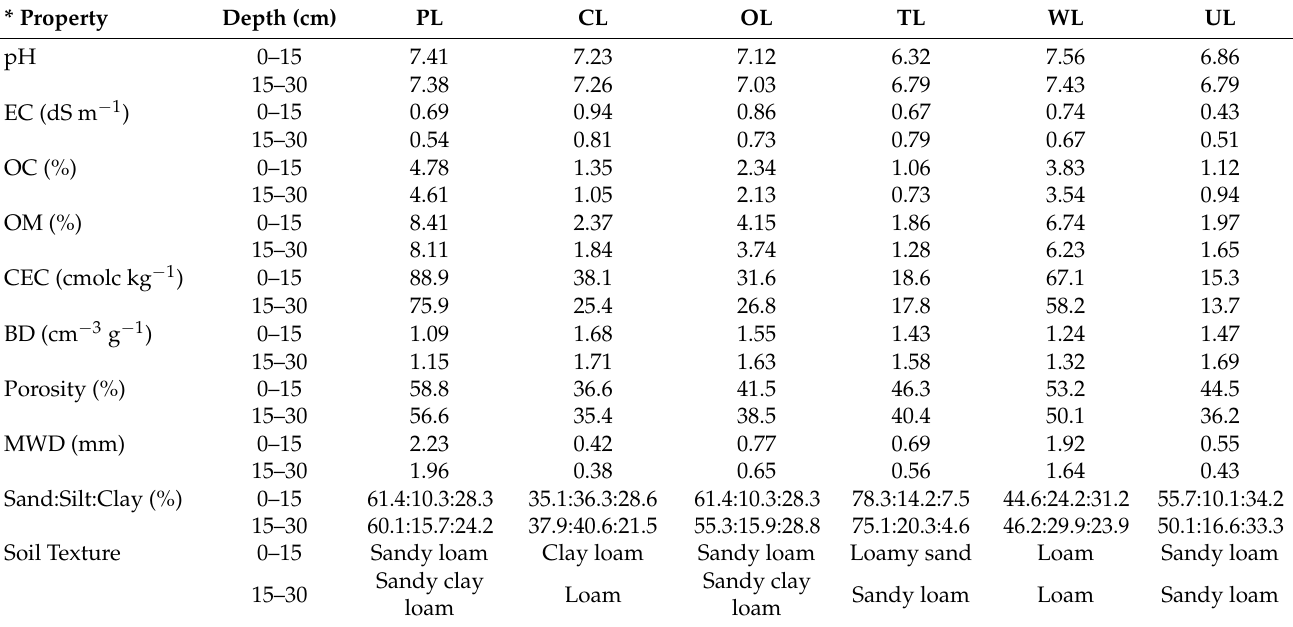
Table 1. Soil analysis in different land